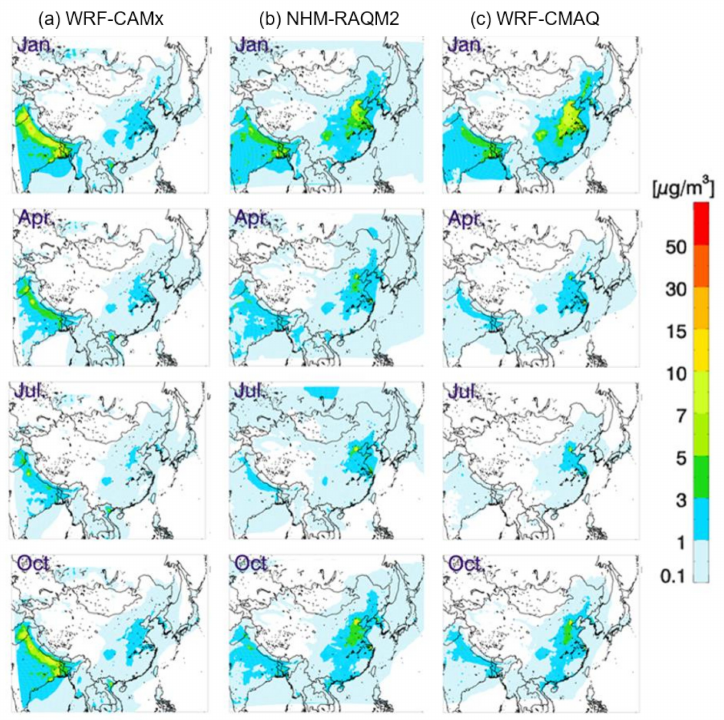
Figure 6. As in Figure 2, but for elemental carbon (EC) concentrations ( µ g/m 3